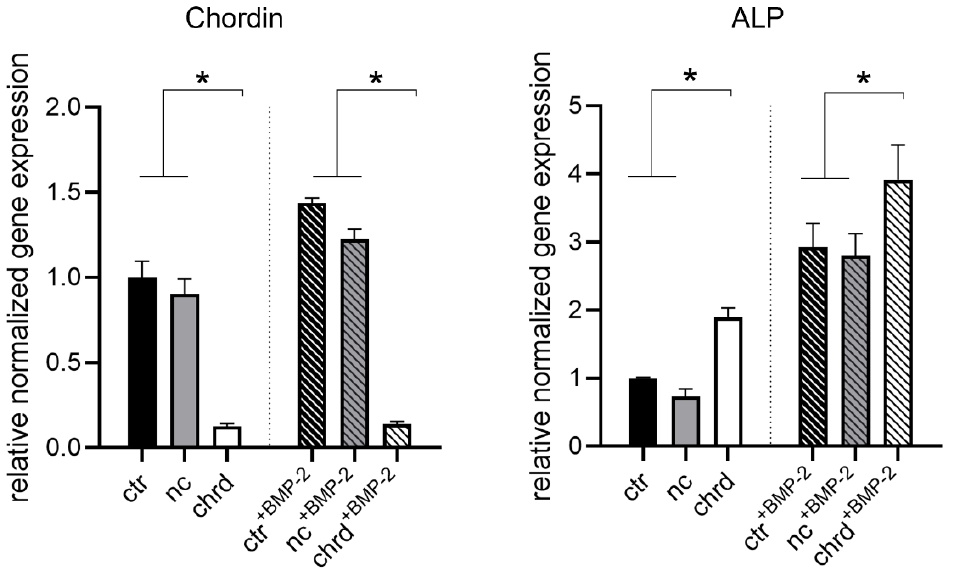
Figure 1. Chordin and alkaline phosphatase (ALP) expression in microtissues assembled from siRNA-loaded cGM and hMSC after 4 days in an osteogenic medium with or without BMP-2 (ctr: non-treated control, nc: non-coding siRNA, chrd: chordin siRNA). Statistically significant differences ( p < 0.05) are indicated with (*).